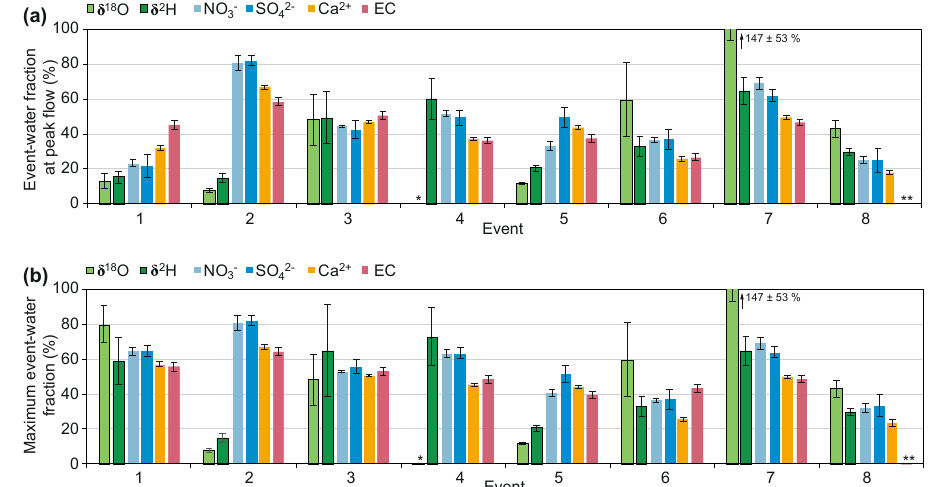
Figure 9. Event-water fractions ( F E ) based on isotopic and chemical hydrograph separation for eight storm events. Panel (a) shows F E during peak flow, and panel (b) shows the maximum event-water fractions ( F E , max ) of each event. Unrealistic F E and F E , max values based on δ 18 O were obtained for Event 4 because the isotopic signatures in precipitation and pre-event stream water were too similar ( ∗ ). For Event 8, the wash-off of road salt resulted in unrealistic F E and F E , max values based on EC: − 96 ± 6 and − 95 ± 6% ( ∗∗ ), respectively. The larger uncertainties in the IHS results compared to CHS can be explained by the large temporal variability of the isotope values in precipitation, which substantially exceeds the analytical uncertainty during most